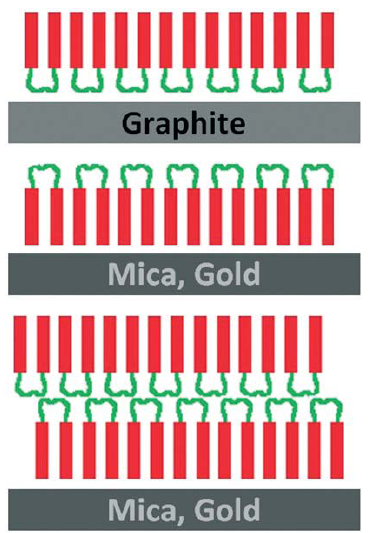
Fig. 8 . Scheme of energy levels in structure metal-DPT composite-metal, illustrating the occurrence of negative differential conductivity.